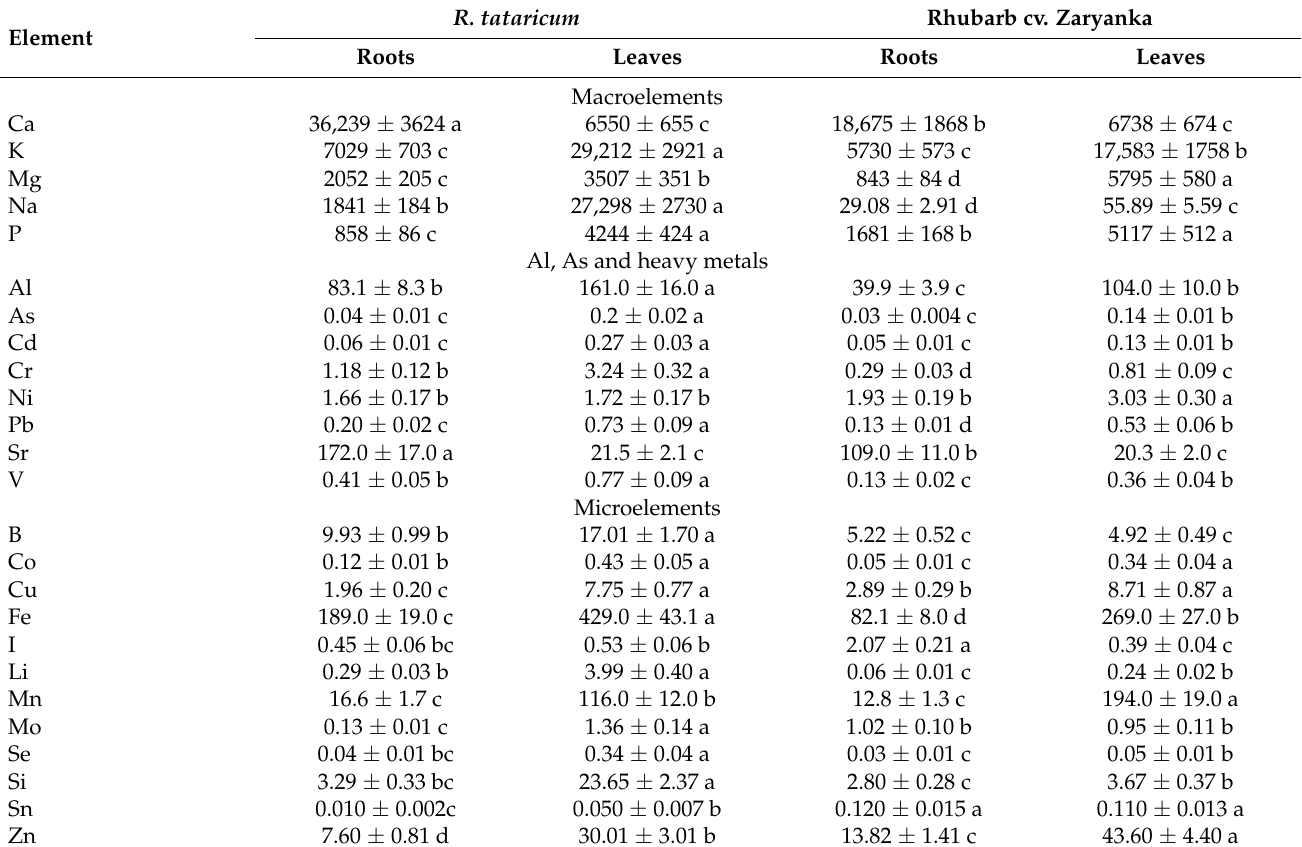
Table 4. Root and leaf mineral composition of R. tataricum and rhubarb cv. Zaryanka (mg kg − 1